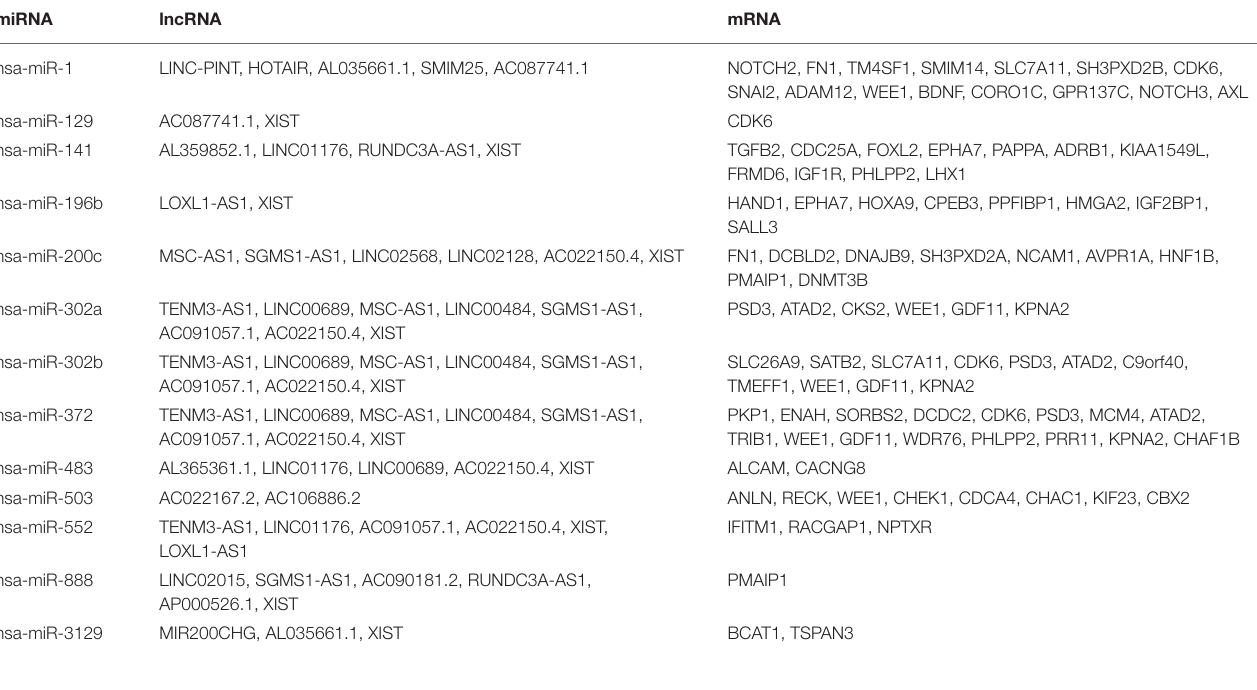
TABLE 2 | The concrete interactions among the lncRNAs, miRNAs, and mRNAs in the ceRNA network.